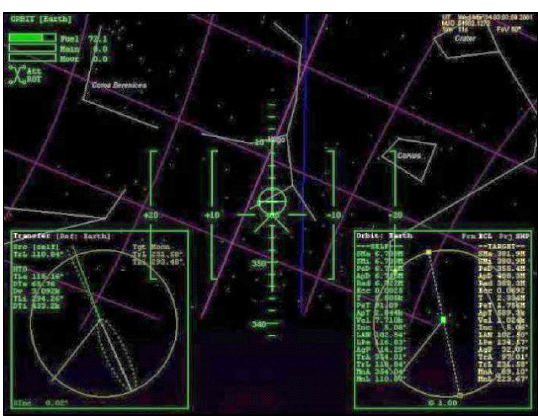
Fig. 10. Orbiter showing a star sensor view [16].